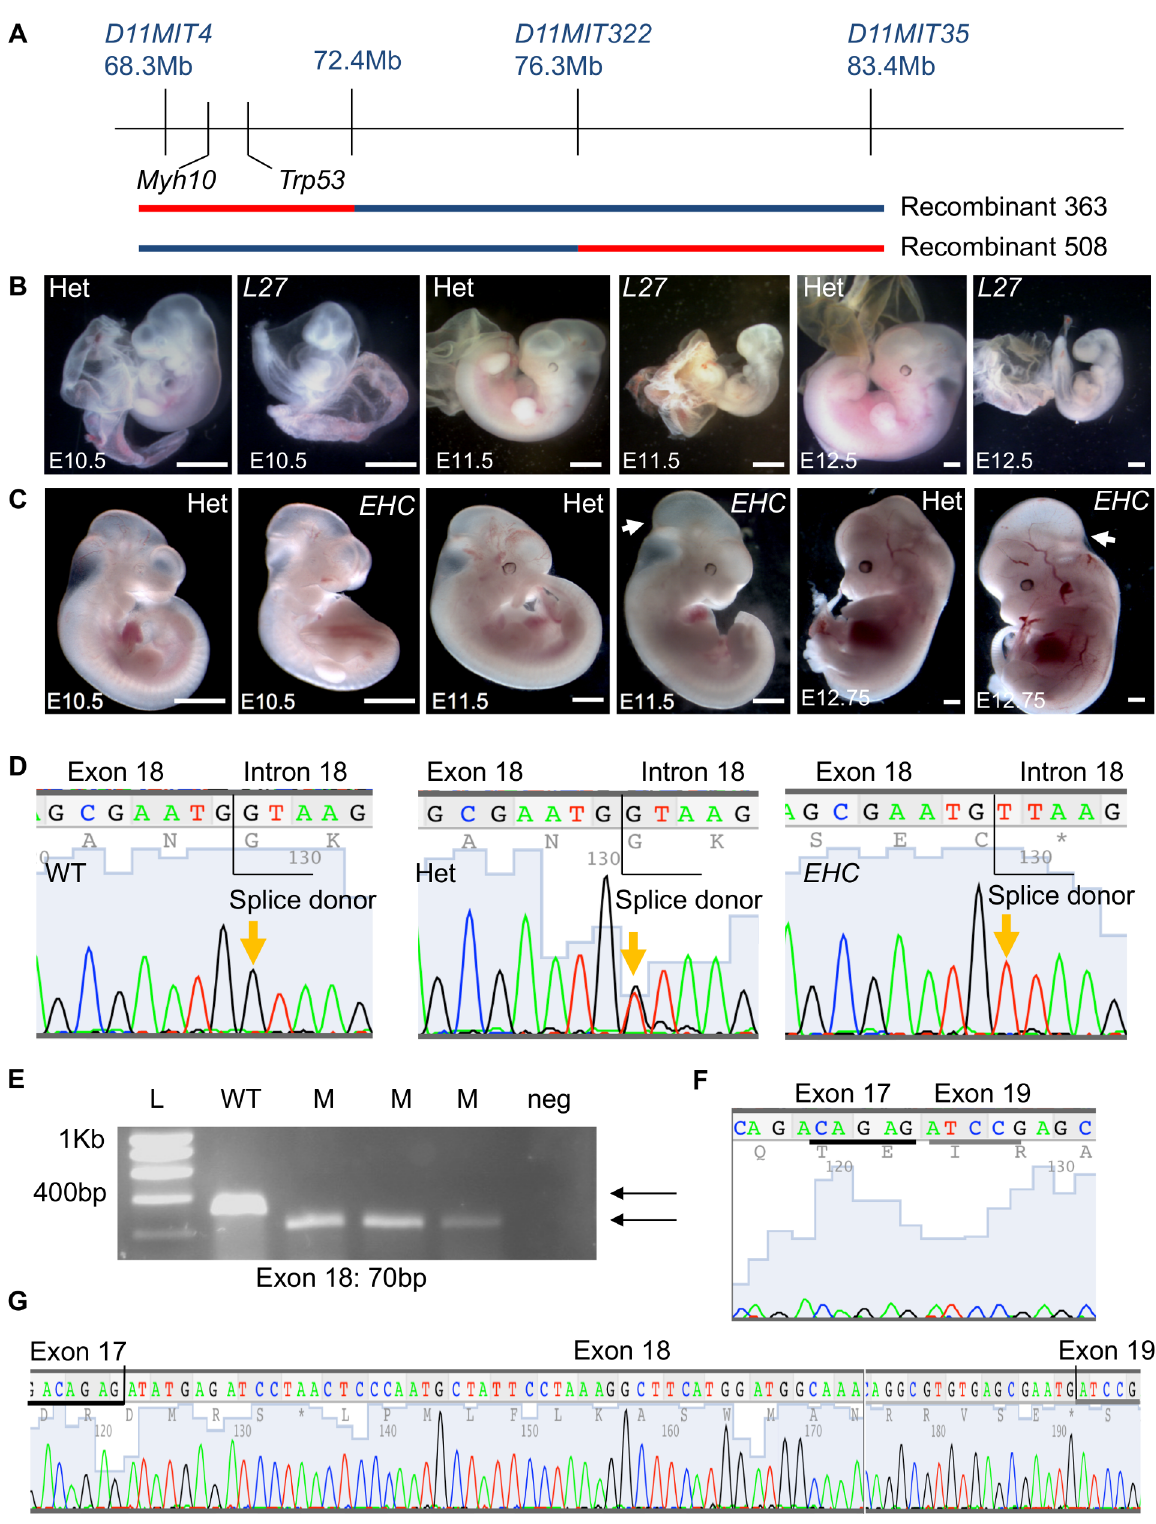
Fig 1. The l11Jus27 mouse line carriestwo embryonic lethal mutations, one of which is in Myh10 . A: Two recombinant mice show linkageof the phenotype(lethality) with distinct sub-regionsof the mouse chromosome 11 balancerinterval. The blue line indicatesthe 129S5 non-mutagenisedchromosome. The C57BL/6region(red) in recombinantmouse 363 extends beyond the